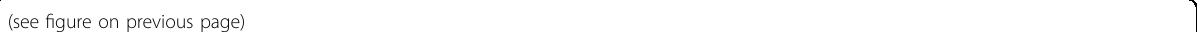
Fig. 2 Inhibition of mTOR signaling reduces the fraction of cancer stem-like cells in human mucoepidermoid carcinoma cells. a Western blots for AKT, p-S473-AKT, mTOR, p-S2448-mTOR, S6K1, p-T421/S424-S6K1, Bmi-1, and B-actin after exposure of bulk MEC tumor cells (UM-HMC-1, UM- HMC-3A, and UM-HMC-3B) to increasing concentrations of AKT inhibitors (0.2 – 20 μ M buparlisib or LY2940002) or vehicle control. Graphs depict the fraction of ALDH high CD44 high cells identi fi ed by fl ow cytometry in MEC tumor cells (UM-HMC-1, UM-HMC-3A, and UM-HMC-3B) after exposure to increasing concentrations of buparlisib, LY2940002, or vehicle control. b Western blots for AKT, p-S473-AKT, mTOR, p-S2448-mTOR, S6K1, p-T421/ S424-S6K1, and Bmi-1 after exposure of bulk MEC tumor cells to increasing concentrations of mTOR inhibitors (0.2 – 20 ng/ml rapamycin or temsirolimus) or vehicle control. Graphs depict the fraction of ALDH high CD44 high cells identi fi ed by fl ow cytometry in MEC tumor cells after exposure to increasing concentrations of rapamycin or temsirolimus. c Western blots for AKT, p-S473-AKT, mTOR, p-S2448-mTOR, S6K1, p-T421/S424-S6K1, and Bmi-1 after exposure of bulk MEC tumor cells to increasing concentrations of S6K1 inhibitor (2 – 200 nM PF4708671) or vehicle control. Graphs depict the fraction of ALDH high CD44 high cells identi fi ed by fl ow cytometry in UM-HMC-1, UM-HMC-3A, and UM-HMC-3B cell lines after exposure to increasing concentrations of the S6K1 inhibitor. d Western blots for mTOR, p-S2448-mTOR, S6K1, p-T421/S424-S6K1, 4E-BP1, and p-S65-4E-BP1 upon exposure of UM-HMC-3A cells to increasing concentrations of temsirolimus for 24 h. e Western blots for mTOR, p-S2448-mTOR, Rictor, and p-T1135- Rictor upon exposure of UM-HMC-3A cells to increasing concentrations of temsirolimus for 24 h. Asterisk depicts p < 0.05, as determined by one-way ANOVA followed by post-hoc tests for multiple comparisons between vehicle-treated and cells that were exposed to experimental compounds. Error bars indicate standard deviation (SD). Graphs for impacts of treatment on the fraction of ALDH high CD44 high cells depict data from four wells per experimental condition. Experiments were performed three independent times to verify reproducibility of the